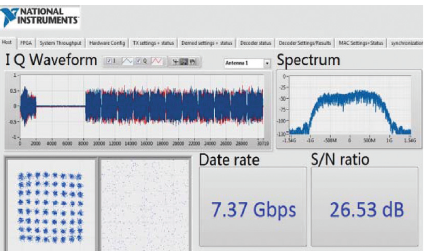
Figure 14: Software panel of the data-rate measurement system [14]. Table 2: Data rate and SNR measurement results. Operation